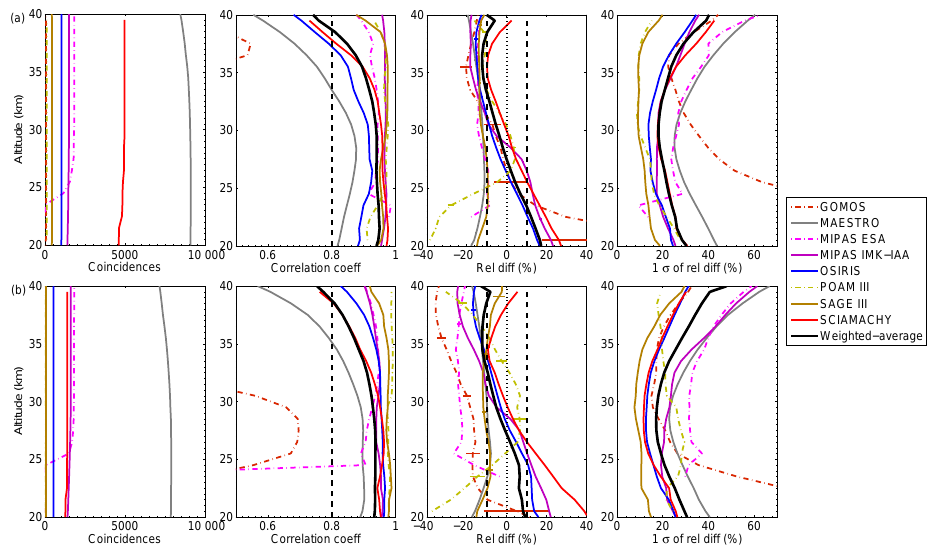
Figure 9. Comparisons of ACE-FTS NO 2 profiles with correlative data sets using coincidence criteria of within 4h and 350km: (a) northern hemispheric data and (b) southern hemispheric data. Note that HALOE has been excluded. Error bars in the relative difference profiles represent the standard error of the mean (values less than ∼ 1% may not be visible).